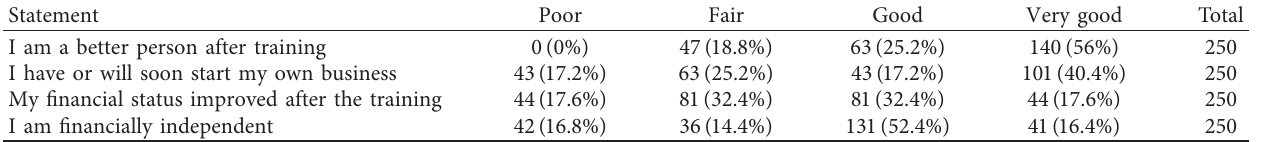
Table 3: Impact of adult literacy and skills acquisition on women